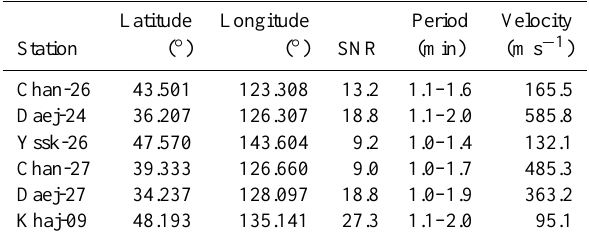
Table 1. The propagation characteristics of observed high- frequency TIDs in terms of location (latitude and longitude), period and average propagation velocity. The SNR is the signal and noise rate. Latitude